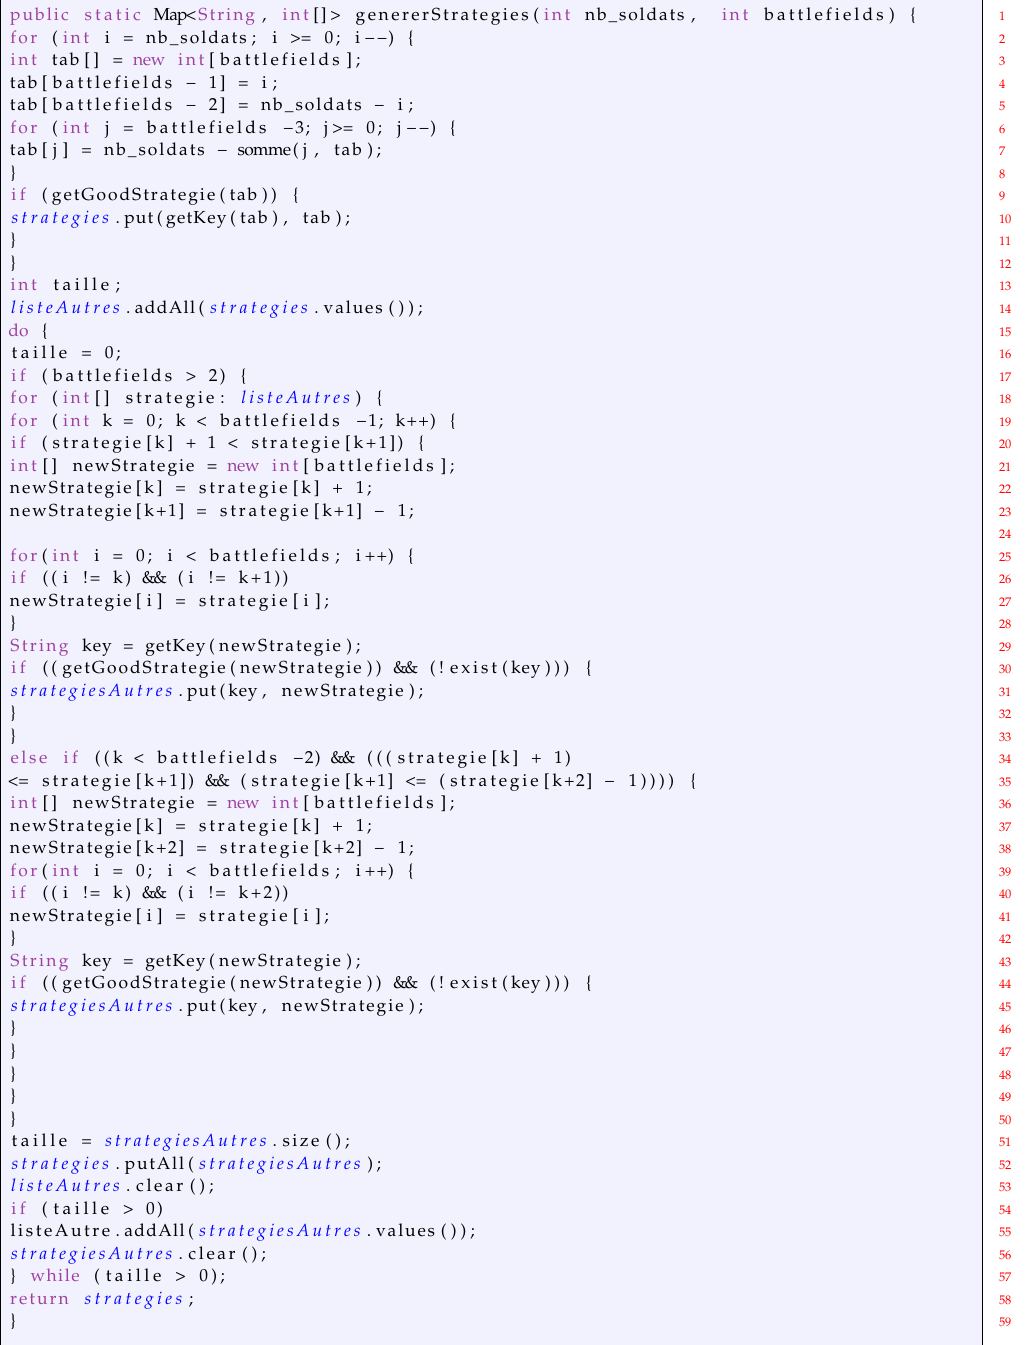
Code A4: Calculation of the complexity of the strategy generation